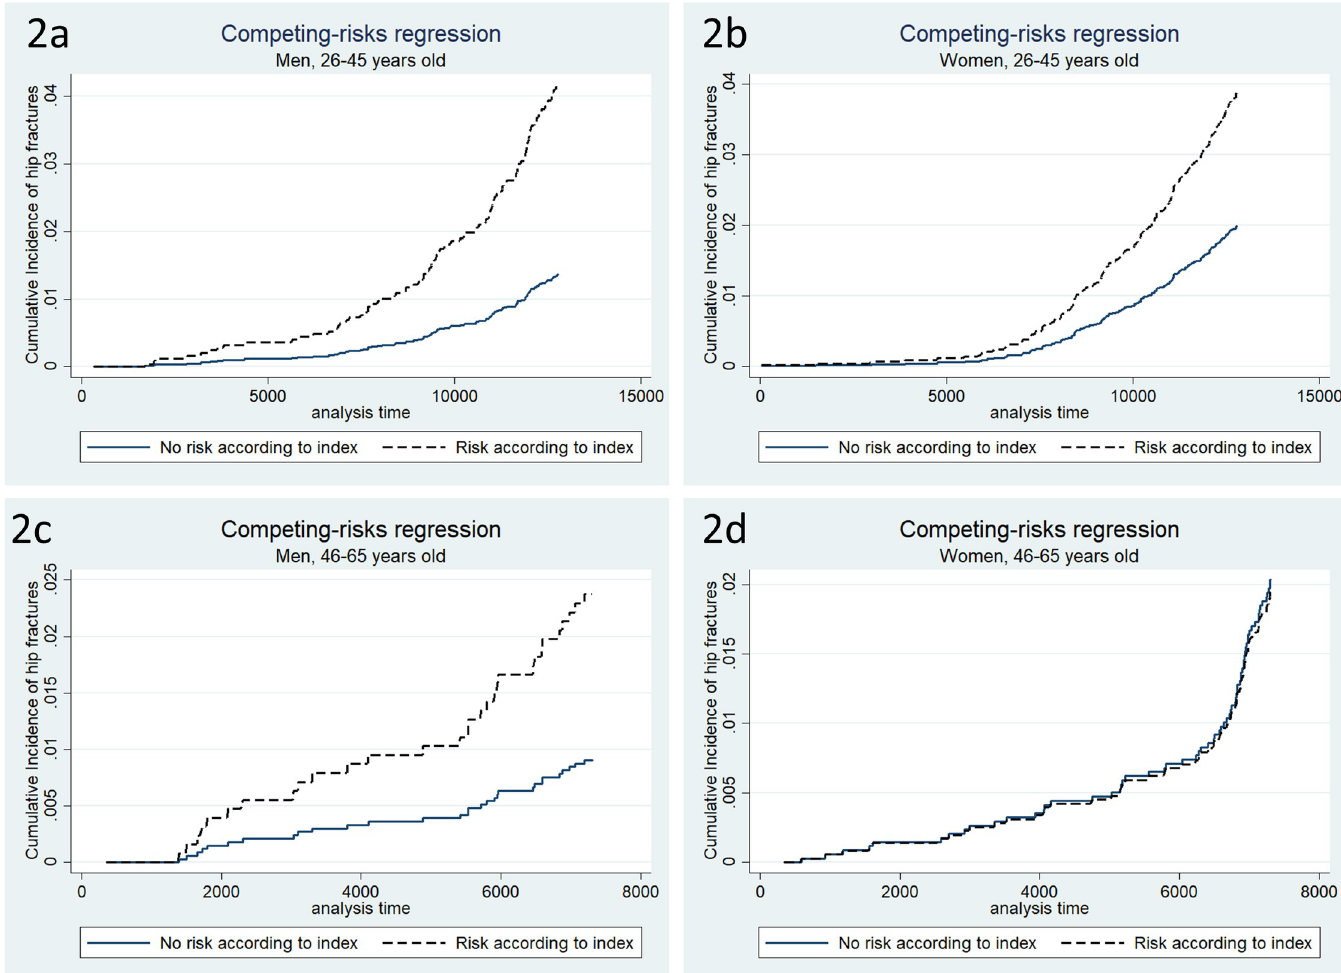
Fig 2. Cumulative incidence function of hip fractures. Cumulative Incidence of hip fractures by gender and age group after using the stcrreg command in Stata for Competing risks regression according to Fine & Gray.